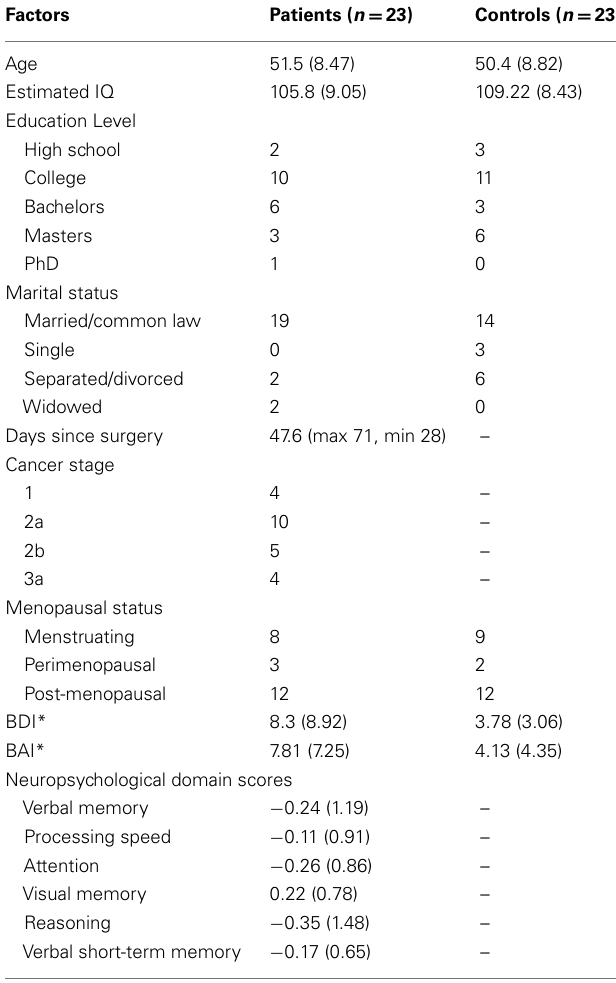
Table 1 | Demographic and clinical data.